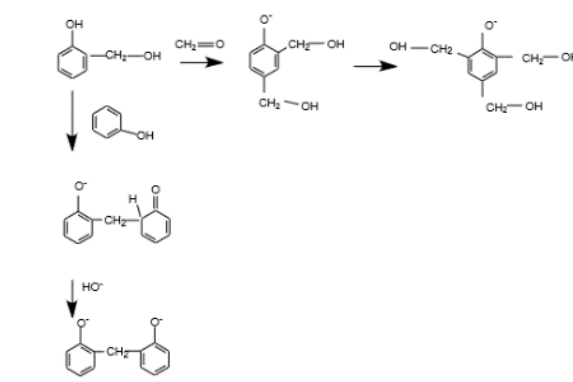
Figure 3. The general mechanism for the development of RF gel networks. Adapted from S.A. Al-Muhtaseb [44].